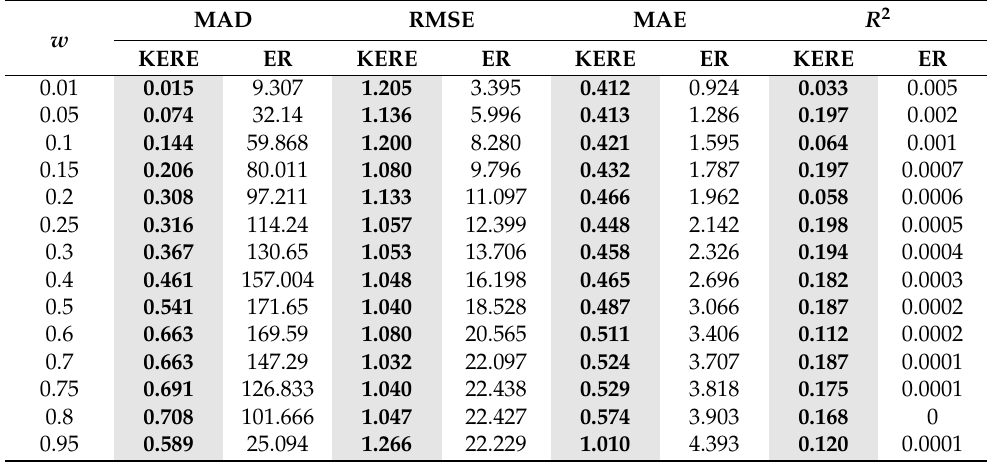
Table 4. Direct emissions. The testing MAD, RMSE and MAE metrics for both KERE and ER are reported with respect to the various expectile levels ranging between 0.01 and 0.99. w